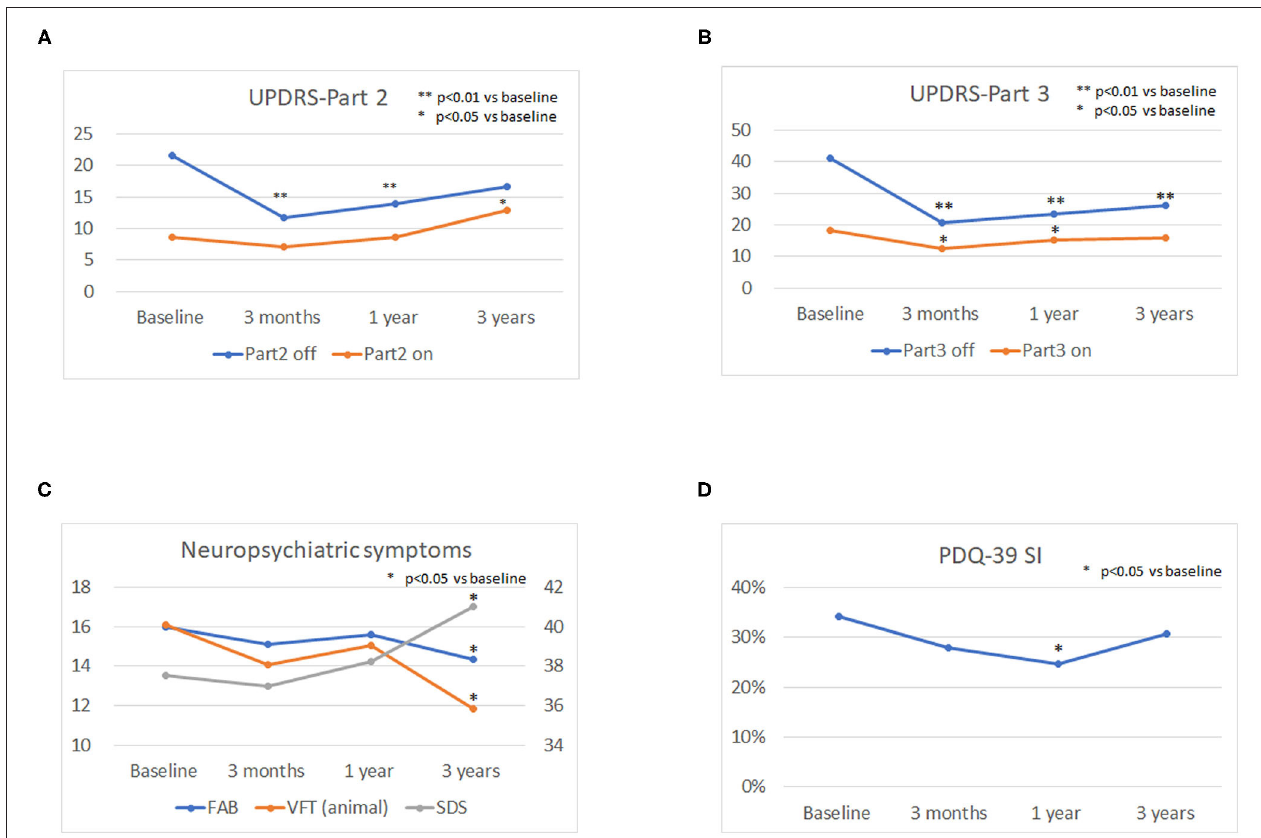
FIGURE 1 | Longitudinal changes in the Unified Parkinson’s Disease Rating Scale (UPDRS) parts II and III scores, neuropsychiatric symptoms, and quality of life (QOL). The mean UPDRS parts II and III scores during the off phase (A,B) and the UPDRS part IV score decreased significantly ( P < 0.01) at each follow-up point after surgery compared to the baseline scores. The mean UPDRS part II scores during the on phase did not significantly change 3 months and 1 year after surgery and significantly increased 3 years after surgery (A) . The mean UPDRS part III score during the on phase significantly decreased 3 months and 1 year after surgery, and the difference was not significant until 3 years after surgery (B) . The depression (SDS) score significantly worsened 3 years after surgery ( P = 0.021). The verbal fluency test (VFT) score in the animal portion was significantly worse 3 years after surgery than before surgery ( p < 0.01) (C) . The mean PDQ-39 SI significantly decreased from baseline to 1 year after surgery ( p = 0.015) (D)